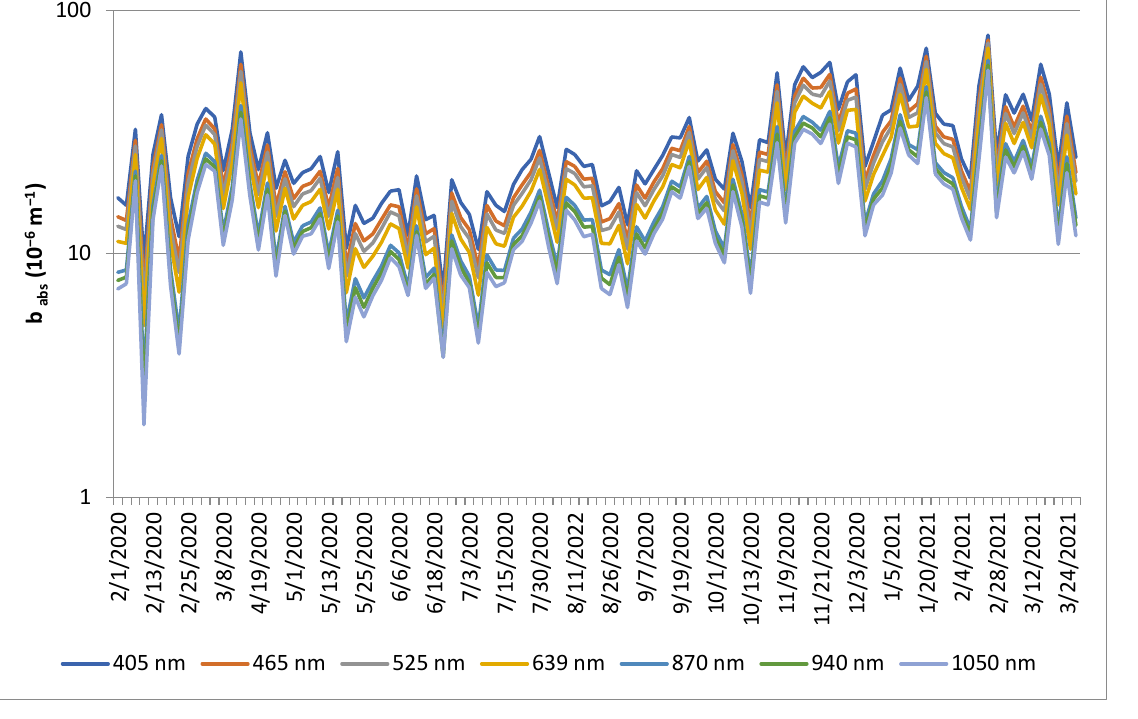
Figure 3. The light absorption coefficients (b abs ) at seven wavelengths (nm) for sampling